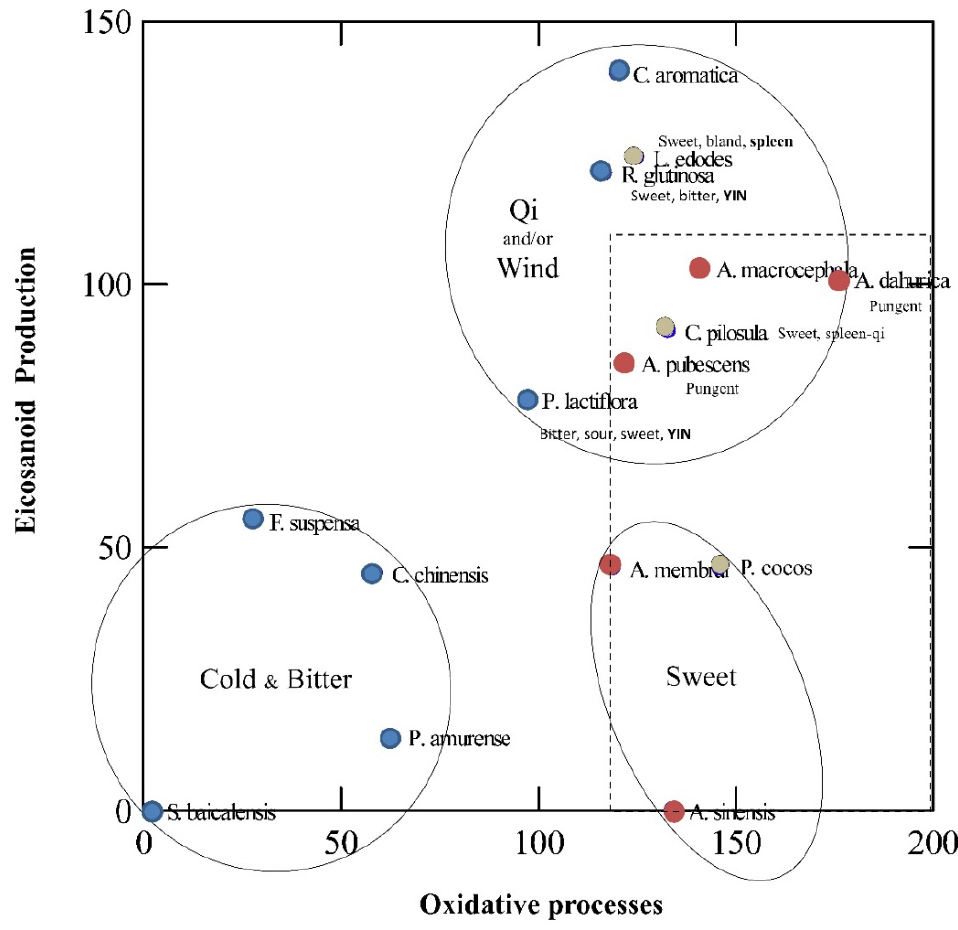
Figure 15. Scatterplot of the lipoperoxidative activity ( X axis, α values) vs. COX-1/5-LOX inhibition ( Y axis, β values). Blue spots: Cold Herbs; Red spots: Warm/Hot Herbs; Grey spots: Neutral Herbs.